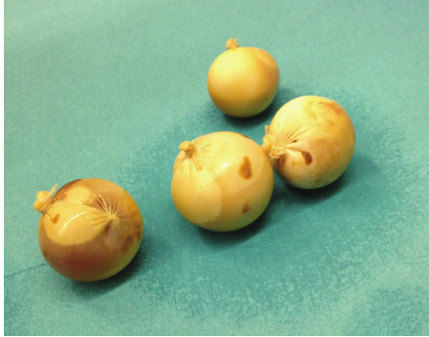
Figure 2: Foreign bodies removed from the